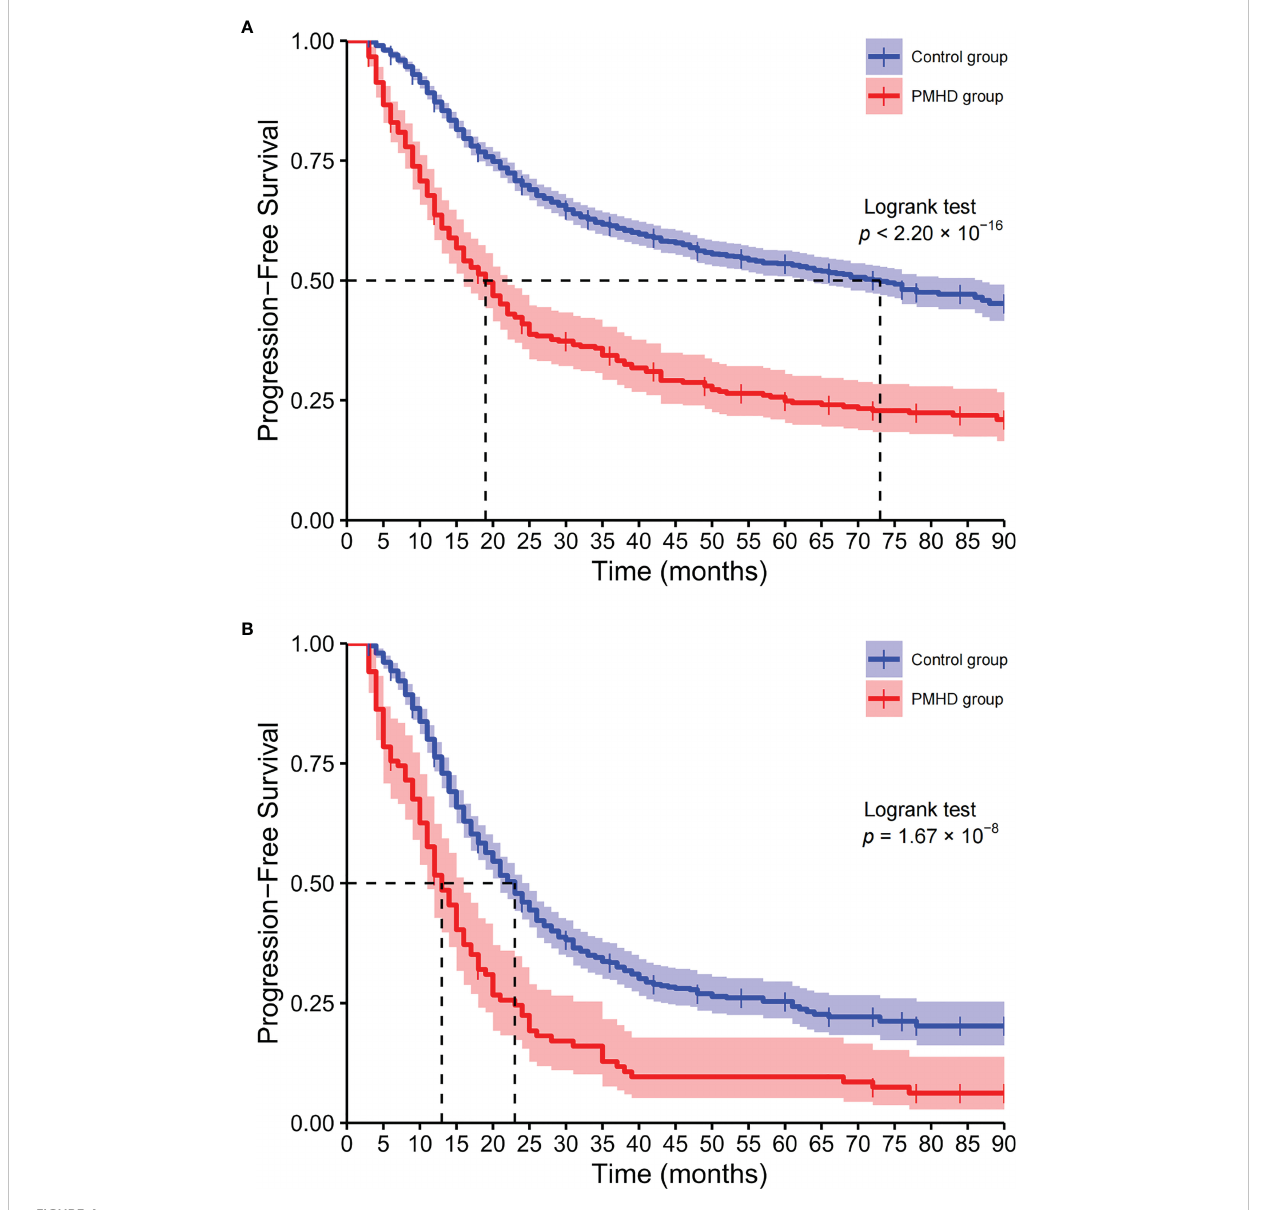
FIGURE 4 Kaplan − Meier curves of overall survival. Kaplan-Meier plots of overall survival for all glioma patients (A) and glioblastoma, IDH-wildtype (B) patients (PMHD group in red, control group in